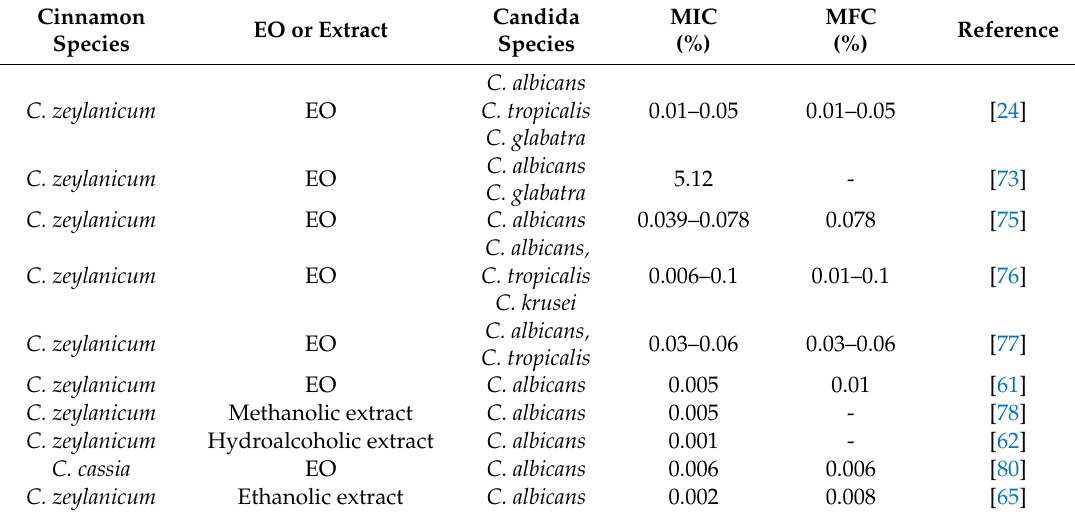
Table 3. Minimal inhibitory concentration (MIC) and minimal fungicidal concentration (MFC) of cinnamon EO and cinnamon